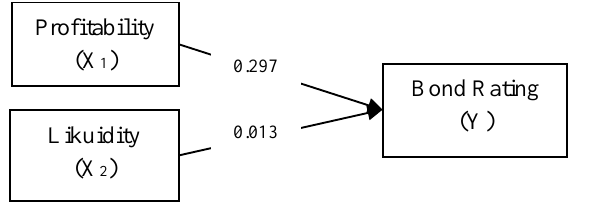
Figure 2: Result of Path Analysis First Model